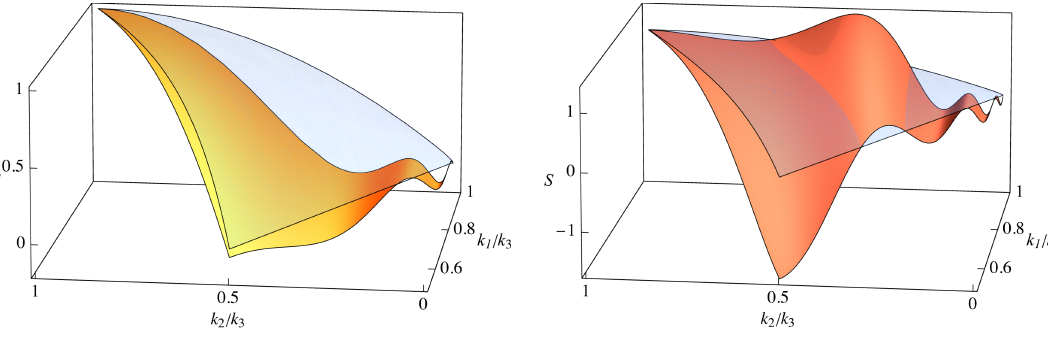
Figure 7 . The equilateral collider shapes S eq . col . ( k 1 , k 2 , k 3 ) with c s /c σ = 10 , µ = 3 ( left ) and c s /c σ = 20 , µ = 5 ( right ). We have also plotted the standard equilateral shape ( blue transparent surfaces ) for comparison. The shapes are normalized to be 1 at the equilateral limit k 1 = k 2 = k 3 = 1